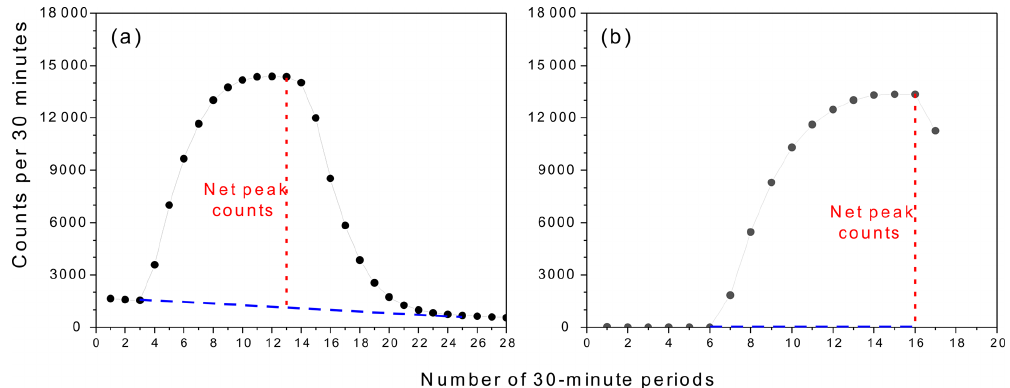
Figure 6. (a) Example of a standard field calibration injection on top of the ambient sampling flow, and (b) an example of a calibration injection on a flow of radon-free air.